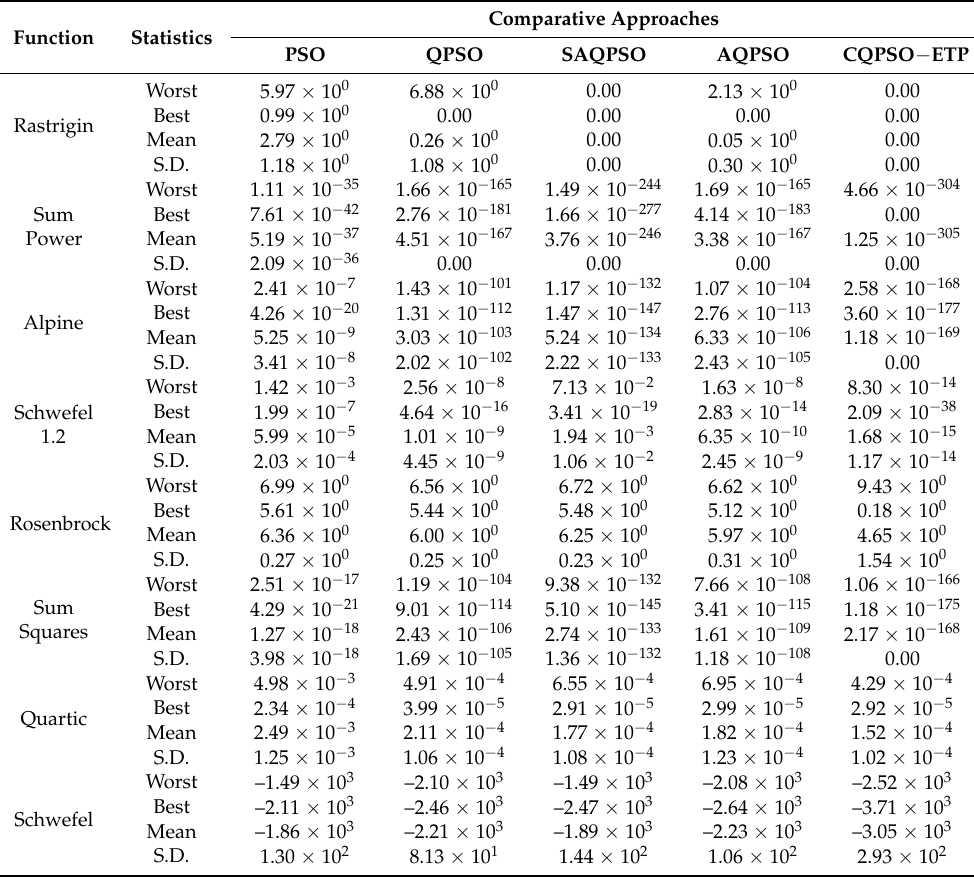
Table 5. Computational results of the comparative approaches on eight numerical benchmark functions ( D =